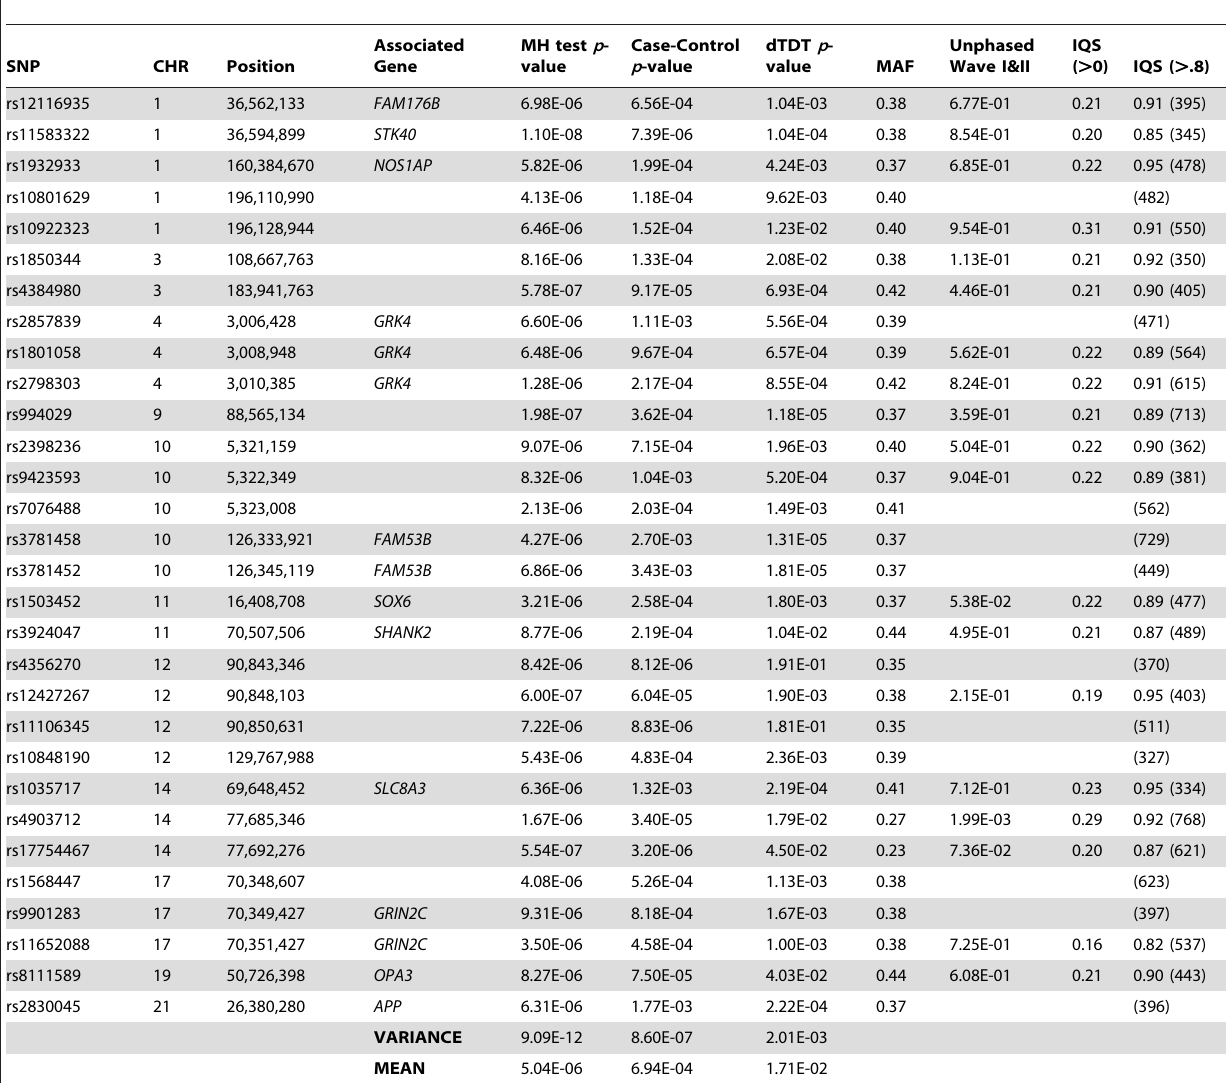
Table 8. Top SNPs with p -values , 10 2 5 from MH test, and corresponding genes and p -values from Case-Control study, dTDT, Unphased association analysis, and IQS with threshold on dosage probabilities above 0.0 or